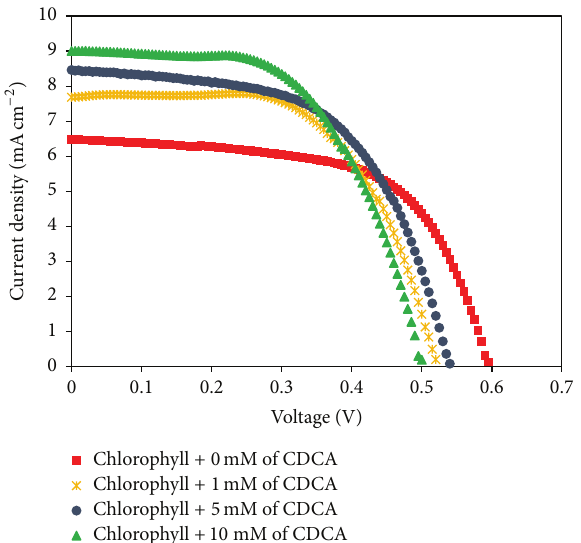
Figure 8: The 𝐽 - 𝑉 characteristics of DSSCs with PVA based double salt electrolytes and chlorophyll added with various concentrations of CDCA.